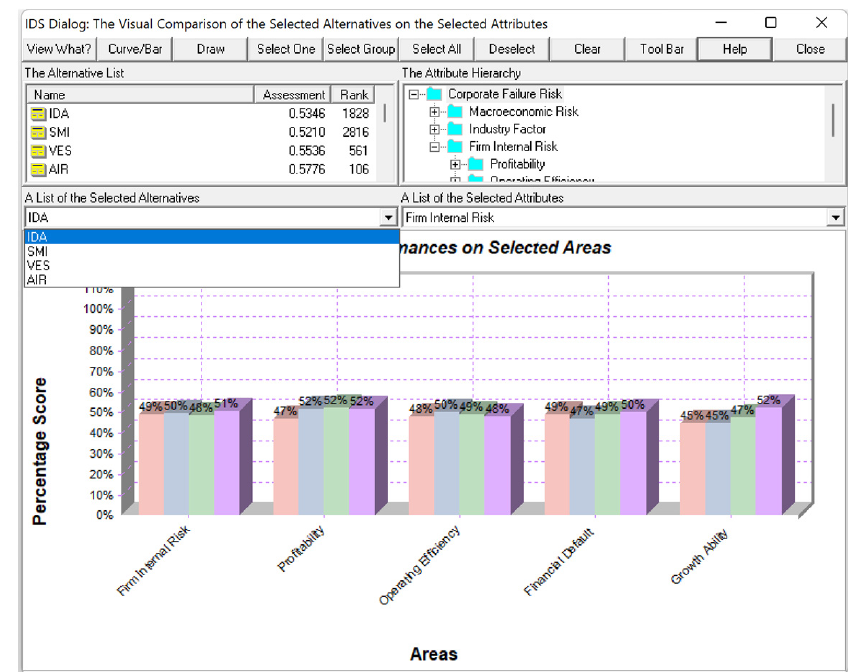
J. Risk Financial Manag. 2022 , 15 , x FOR PEER REVIEW